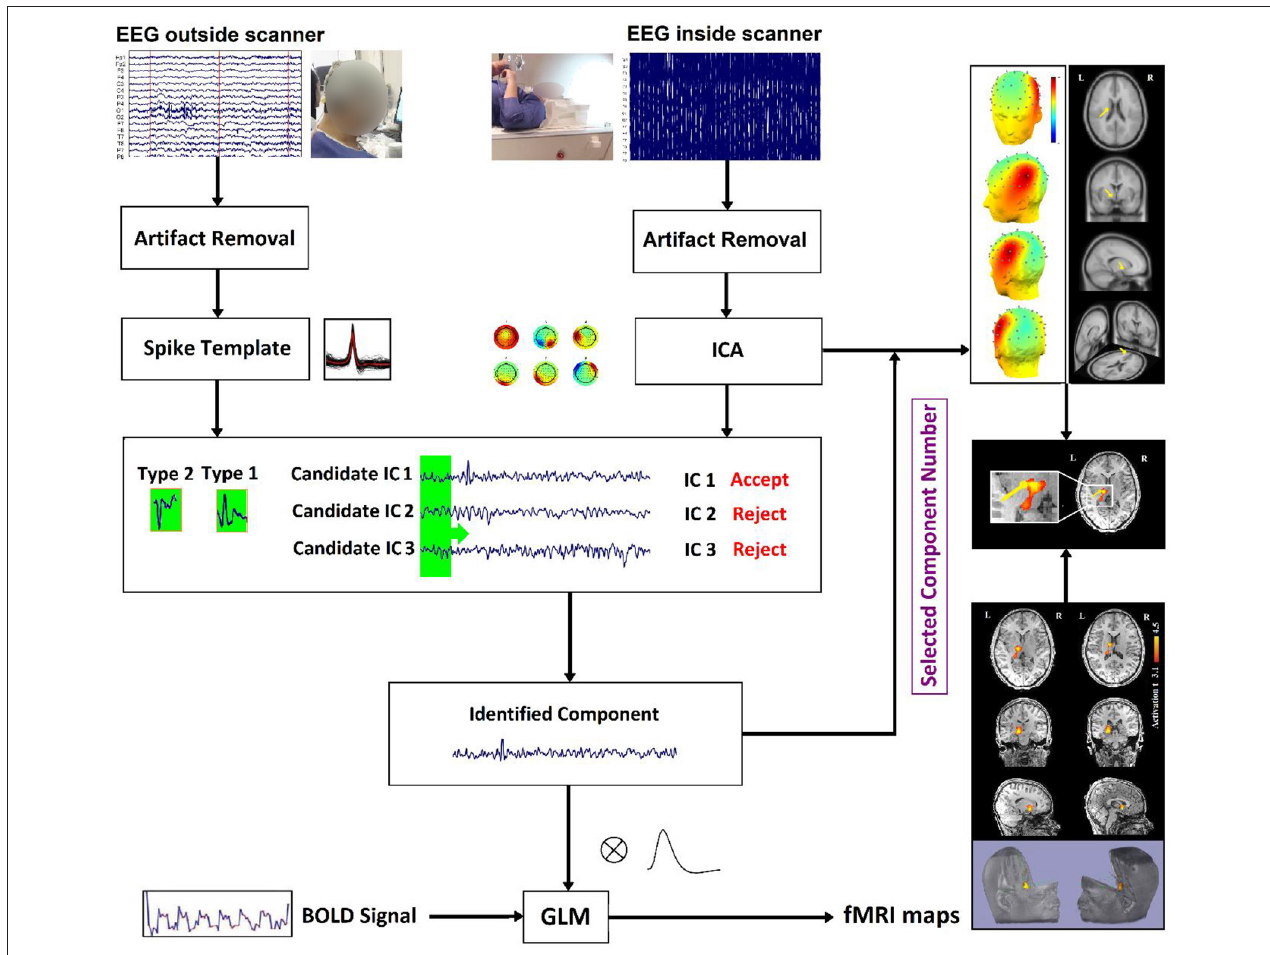
FIGURE 6 | The model of the proposed approach in (22) to identify the components.